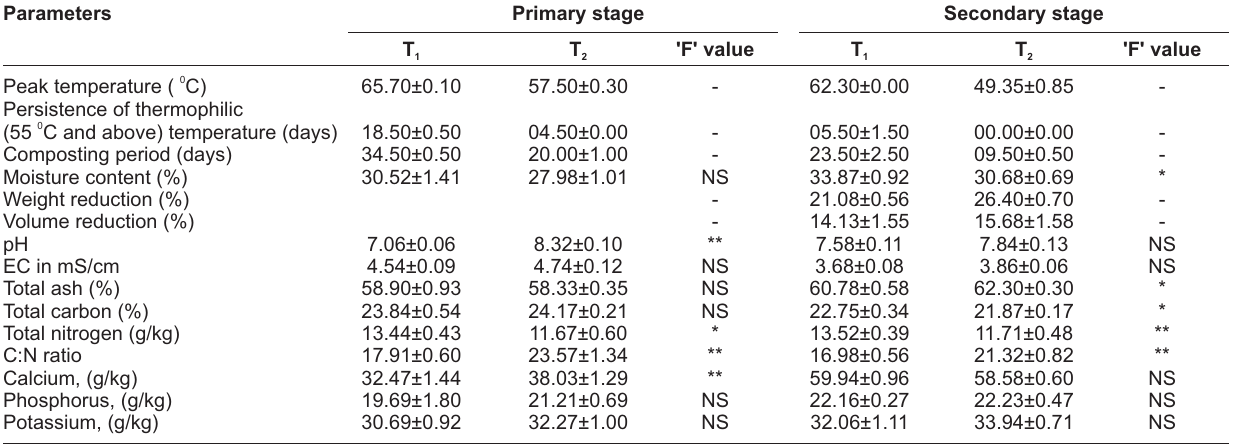
Table-1: Mean ± SE of physical and chemical properties of poultry waste compost Parameters Primary stage